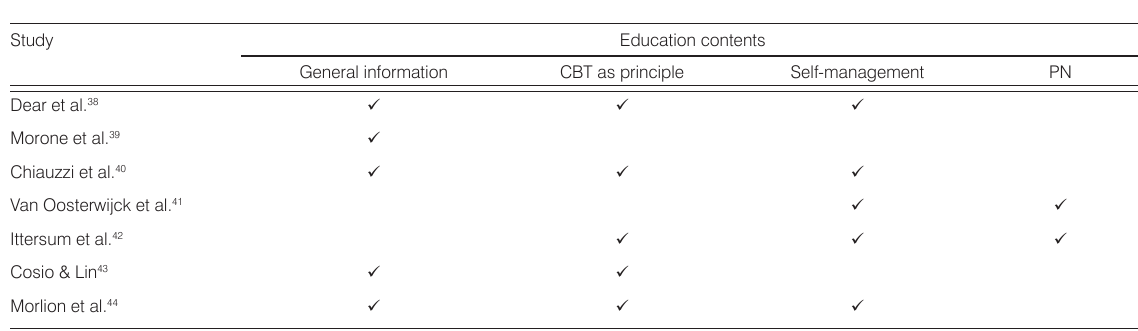
Table 2. Education